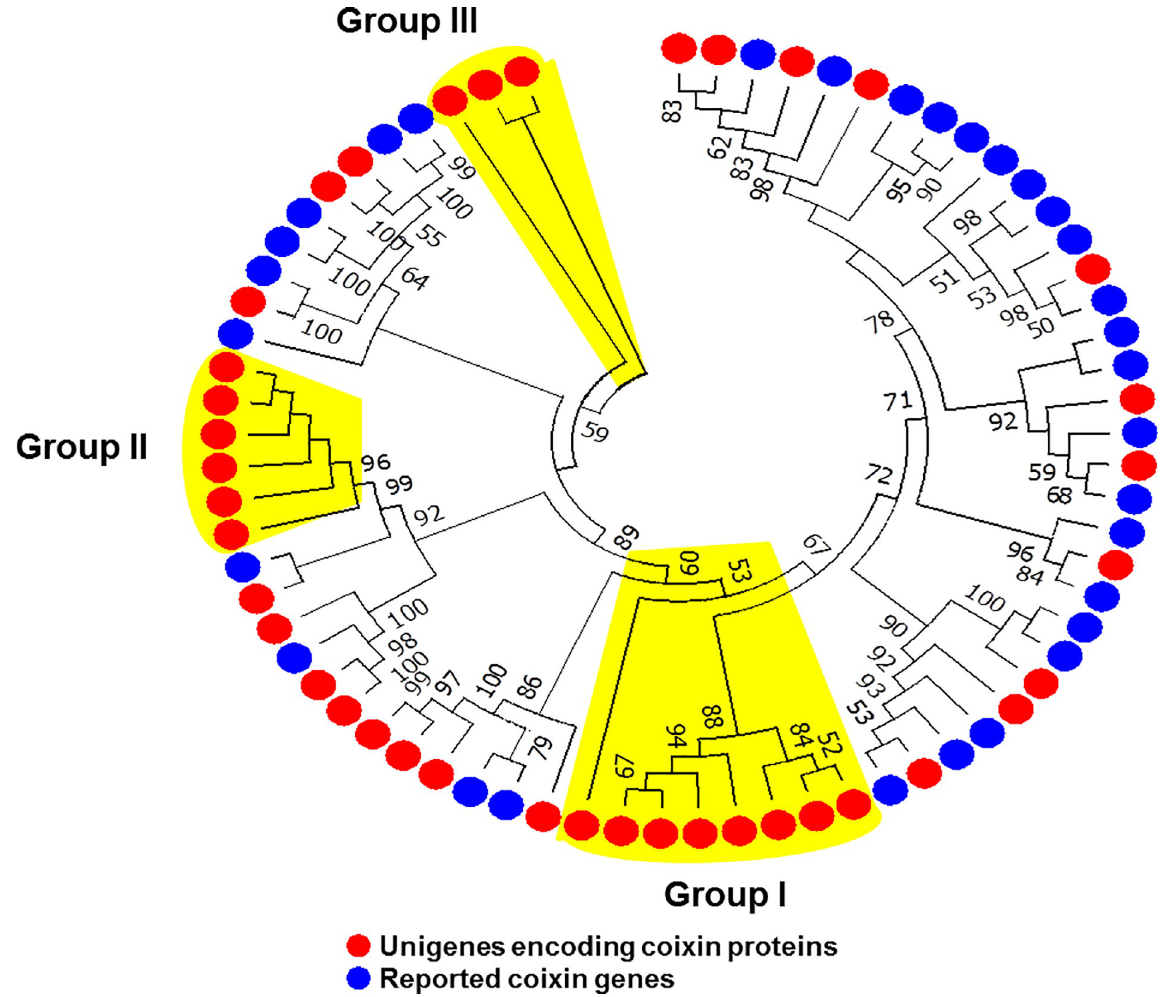
Fig 4. Phylogenetic tree of prolamin-encoding genes. Tree was based on amino acid sequence similarity between predicted genes (red circles) from this study and reported genes (blue circles) in adlay. Gene IDs and gene names are omitted for the sake of legibility (Detailed information can be found in S11